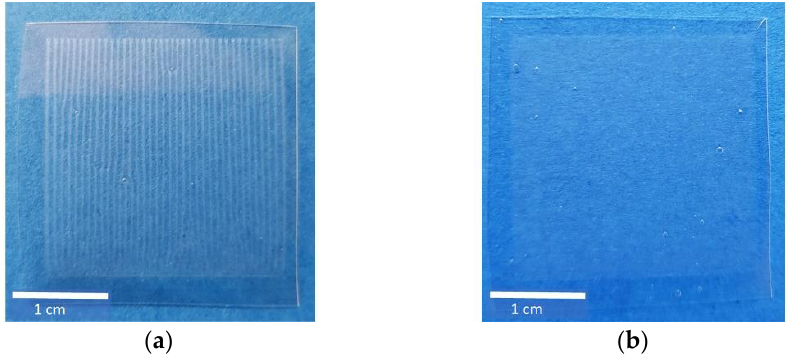
Figure 2. Ink formulations I5 ( a ) and I7 ( b ), printed on HPMC-ODFs using a resolution of 500 dpi, resulting in 500 × 500 drops on an area of 1 inch 2 (≈6.45 cm 2 ).